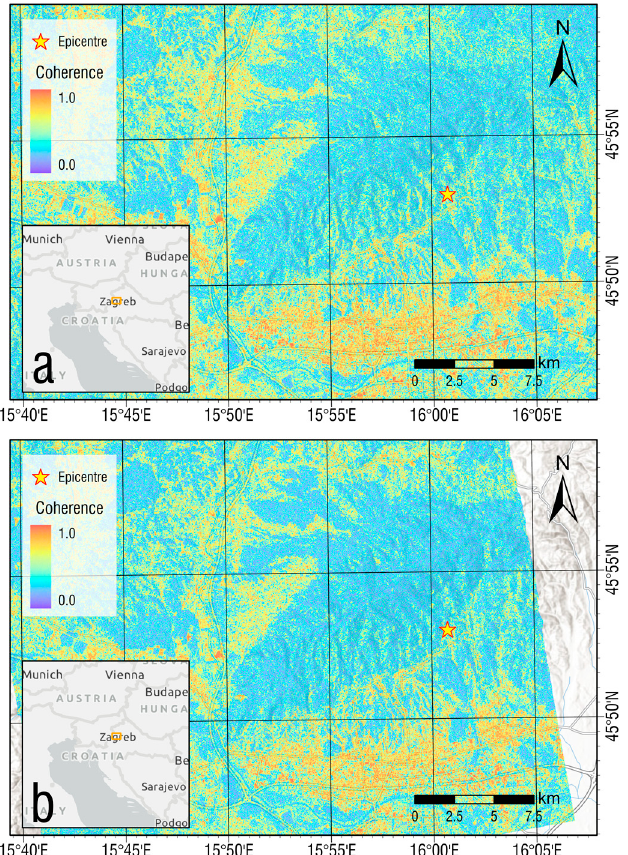
Figure 8. Estimated coherence for: ( a ) Sentinel-1A interferometric pair (17 and 29 March 2020); ( b ) Sentinel-1B interferometric pair (11 and 23 March 2020).